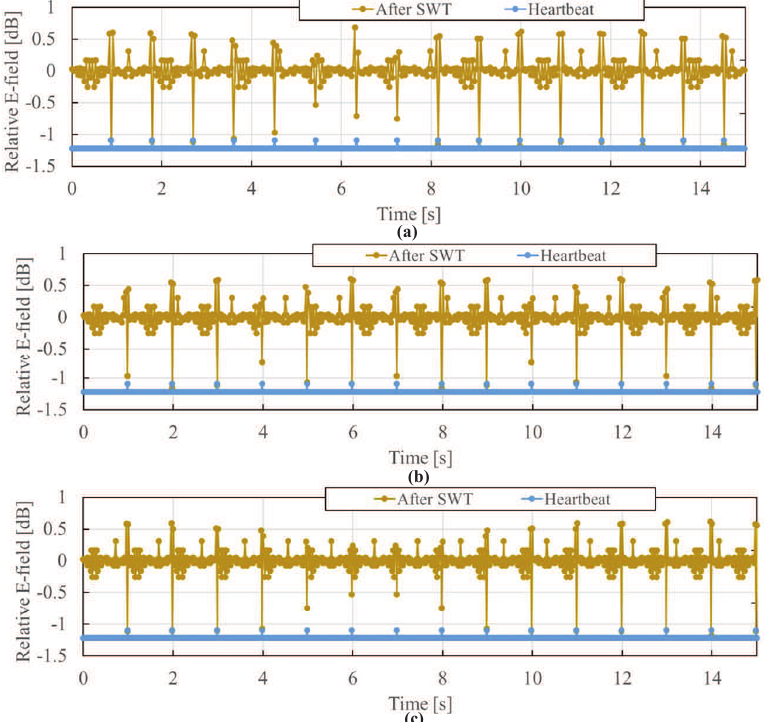
Figure 11. Time waveform of extracted transmitted electric field after SWT at Sensor C. Body movement frequency: ( a ) 0.6 Hz, ( b ) 0.8 Hz, ( c ) 1.0